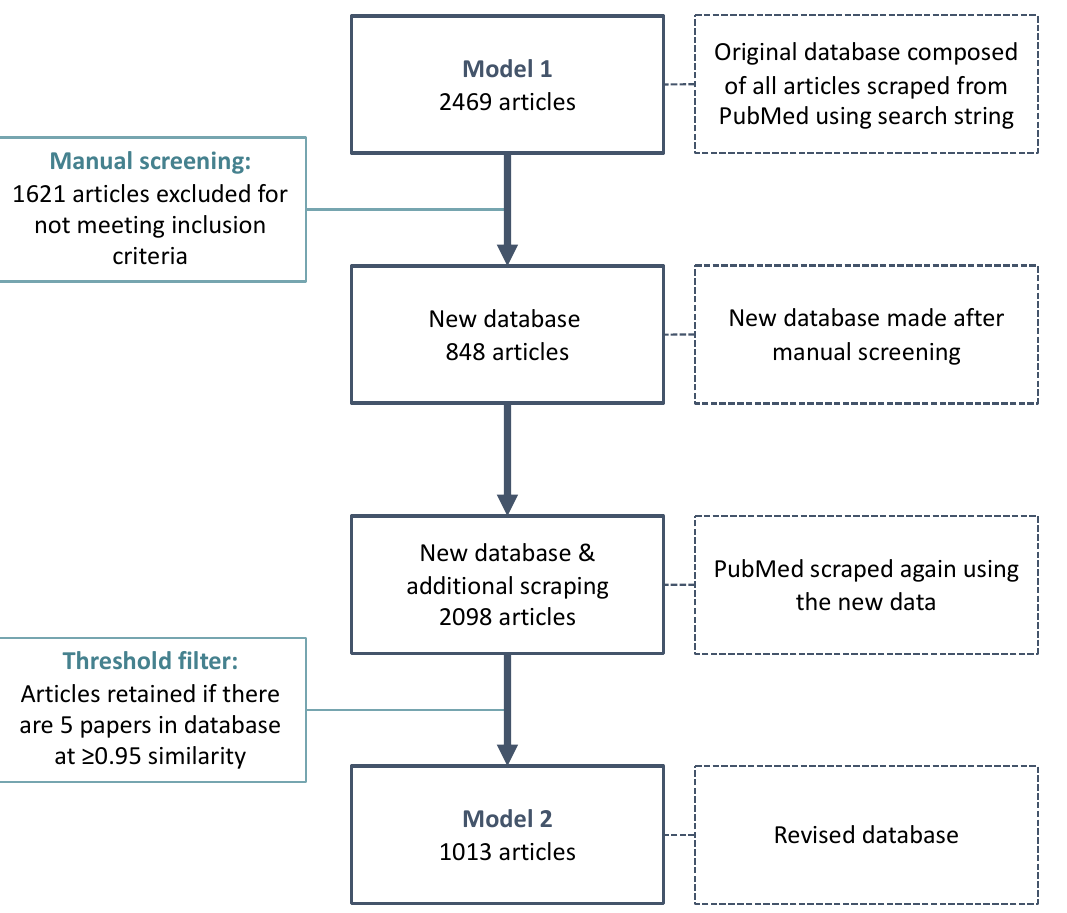
Figure 2. Text mining model development flowchart. Table 1. Manual Labelling Results for Model 1 of the Text-Mining